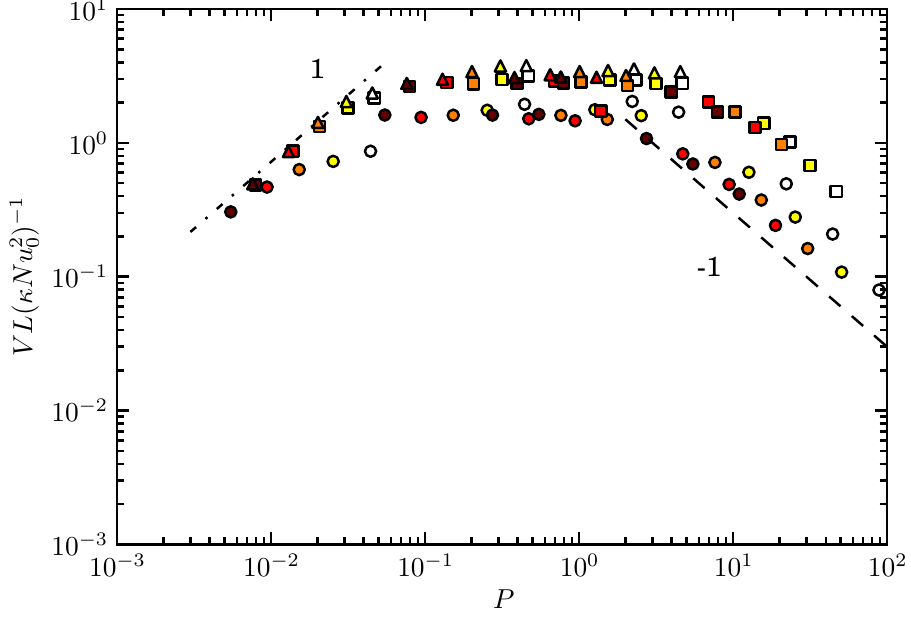
Figure 8. The azimuthal velocity scale, scaled following Read [16], as a function of P . The dashed-dotted line has a gradient of 1 and thus it is clear that the azimuthal velocity scale increases approximately linearly with P at low P . The dashed line has a gradient of 1 showing that for P > 1 the velocity scale − tends to the thermal wind scale. Symbols have the same meaning as in Figure